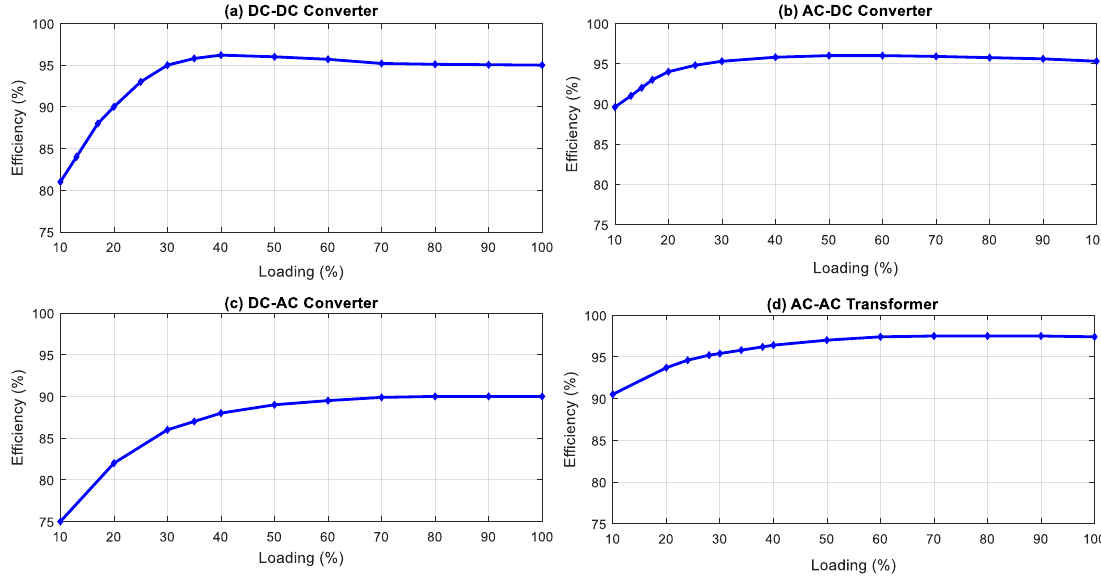
Figure 3. Loading vs. efficiency curves of ( a ) DC-DC converters [34], ( b ) AC-DC converters [35], ( c ) DC-AC converters [36], and ( d ) AC-AC transformers [37].